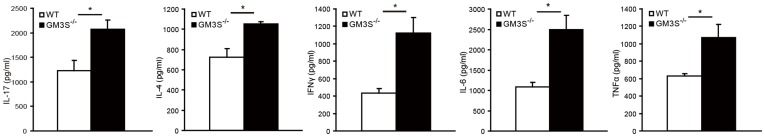
T-cell immune response following anti-CD3 antibody stimulation.Serum levels of IL-17, IL-4, IFNγ, IL-6, and TNFα at 1.5 h after intraperitoneal administration of 20 µg anti-CD3 antibody (n  = 5 per group). Data shown are mean ± SEM. *P<0.05, compared to WT mice.